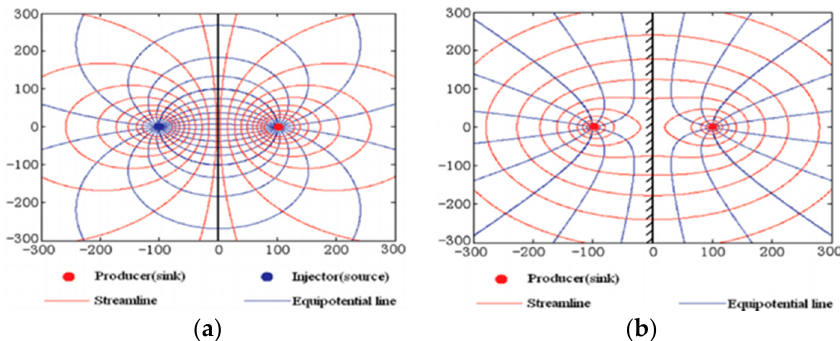
Figure 3. The mirror-image method and source–sink theory applied in different boundaries: ( a ) constant pressure boundary; ( b ) closed boundary.